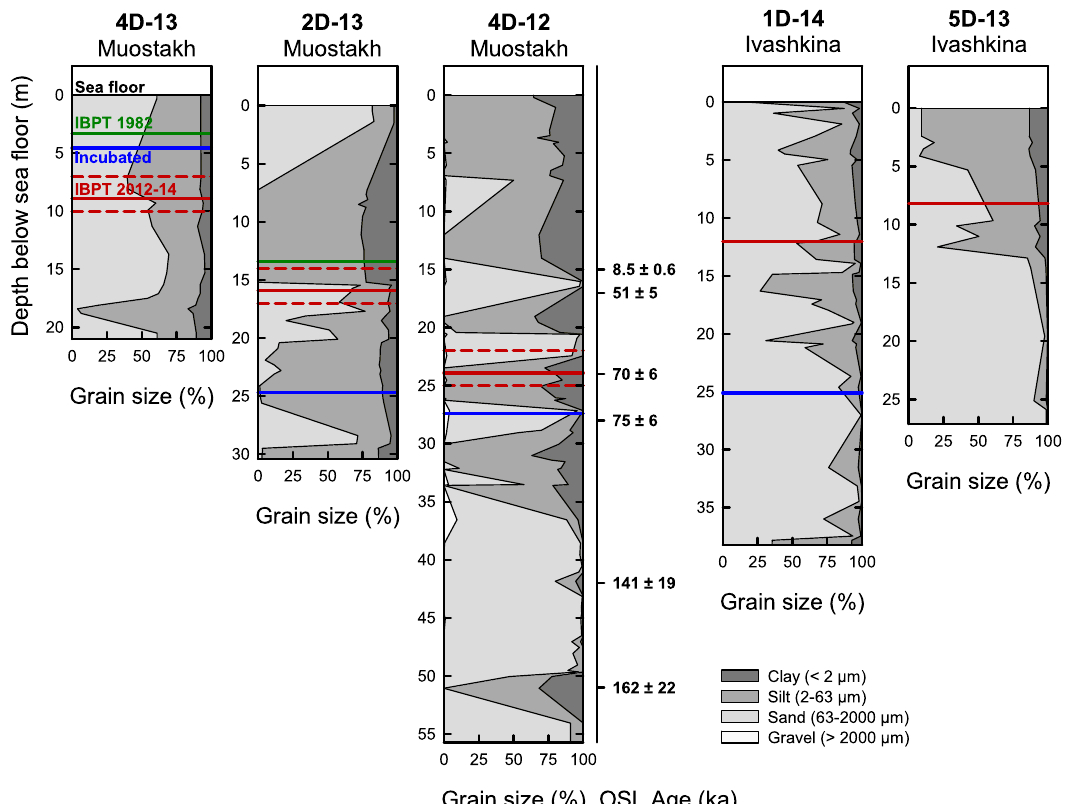
Fig. 2 | Grain size distribution and optically stimulated luminescence (OSL) ages ofsubsea permafrost cores. Cores were drilled nearMuostakh Island and in the Ivashkina Lagoon in the Buor-Khaya Bay. The position of the ice-bonded per- mafrost table (IBPT) in 2012 – 2014 and 1982 is indicated by red and green lines, respectively. The interval marked between dashed red lines shows the thaw front